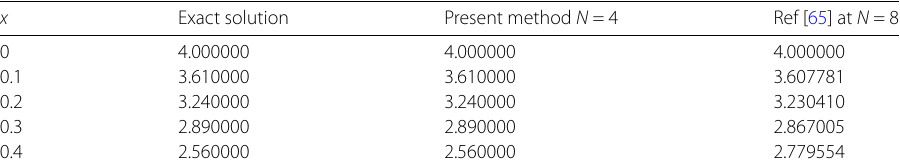
Table 2 Numerical solution of Example 4 for different N